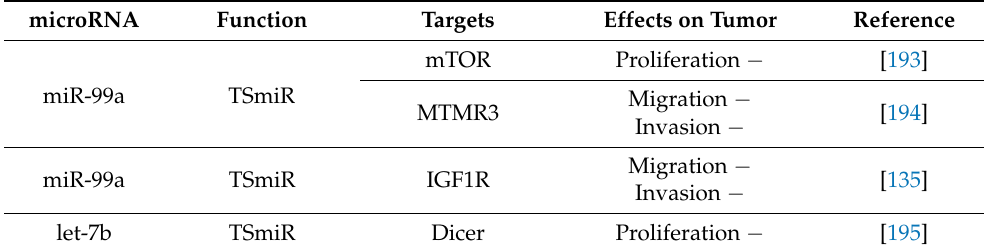
Table 2. Cont. microRNA Function Targets Effects on Tumor Reference mTOR Proliferation − [193] miR-99a TSmiR Migration − [194] MTMR3 Invasion − Migration − [135] miR-99a TSmiR IGF1R Invasion − let-7b TSmiR Dicer Proliferation − [195] Both ( − ) and (+) mean microRNAs show inhibitory or stimulative effect on head and neck cancer, respectively. Abbreviations: ADAM10, ADAM metallopeptidase domain 10; AKT1, AKT serine/threonine kinase 1; ARID1A, AT-rich Interaction domain 1A; AXIN, Axis inhibition protein 2; BCL-2, B-cell lymphoma 2; BRD4, Bromodomain- containing protein 4; CDC42/73, Cell division cycle 42/73; CDK2AP1, Cyclin-dependent kinase 2-associated protein 1; c-MET, Hepatocyte growth factor receptor; CXCR4, C-X-C chemokine receptor type 4; DDR1, Discoidin domain receptor-1; DKK1, Dickkopf wnt signaling pathway inhibitor 1; DND1, RNA-binding protein dead end 1; DNMT3B, DNA (cytosine-5-)-methyltransferase 3 beta; EGFR, Epidermal growth factor receptor; ET-1, Endothelin- 1; EZH2, Enhancer of zeste 2 polycomb repressive complex 2; FBXW7, F-Box and wd repeat domain containing 7; FIH, Factor-inhibiting hypoxia-inducible factor; GNAI2, G protein subunit alpha I2; GSK3b, Glycogen synthase kinase 3 beta; HDAC7, Histone deacetylase 7; HIF-1/2A, Hypoxia inducible factor 1/2 alpha; HOXA10, Homeobox A10; IGF1R, Insulin-like growth factor 1 receptor; ITGA3, Integrin subunit alpha 3; K-ras, KRAS proto-oncogene; LAMC1, Laminin subunit gamma 1; MAP2K1, Mitogen-activated protein kinase kinase 1; MDM4, Mouse double minute 4 homolog; MMP1, Matrix metallopeptidase 1; MTMR3, Myotubularin-related protein 3; mTOR, Mammalian target of rapamycin; NEDD9, Neural precursor cell expressed, developmentally down-regulated 9; p27, Cyclin dependent kinase inhibitor 1b; p57, Cyclin dependent kinase inhibitor 1c; PAK1/4, p21-activated kinase 1/4; PAX6, Paired type homeobox 6; Pim-1, Serine/threonine-protein kinase Pim-1; PNP, Purine nucleoside phosphorylase; PRXL2A, Peroxiredoxin like 2a; PTEN, Phosphatase and tensin homolog; PUMA, BCL2 binding component 3; rap1GAP, RAP1 GTPase activating protein; RUNX2, RUNX Family transcription factor 2; SIRT1, Sirtuin 1; SIRT3, Silent information regulator 3; Slug, SNAI2, snail family transcriptional repressor; Smad7, SMAD family member 7; Snai2, Snail family transcriptional repressor 2; SOCS2, Suppressor of cytokine signaling